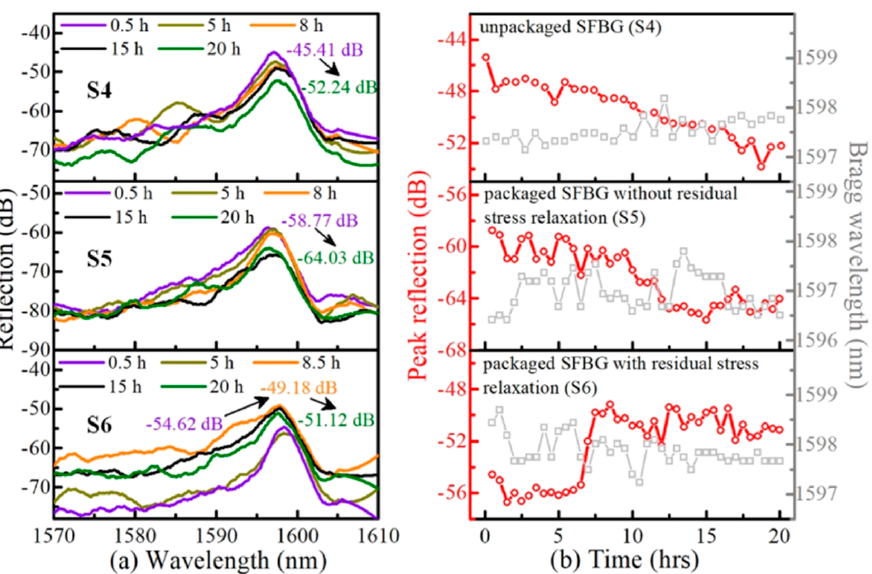
Figure 15. ( a ) Reflective spectral evolutions of SFBG sensors S4–S6 at 1600 ◦ C after 20 h; ( b ) Evolutions of peak reflection and Bragg wavelength of SFBG sensors S4–S6 at 1600 ◦ C after 20 h. (Reprinted with permission from Ref.